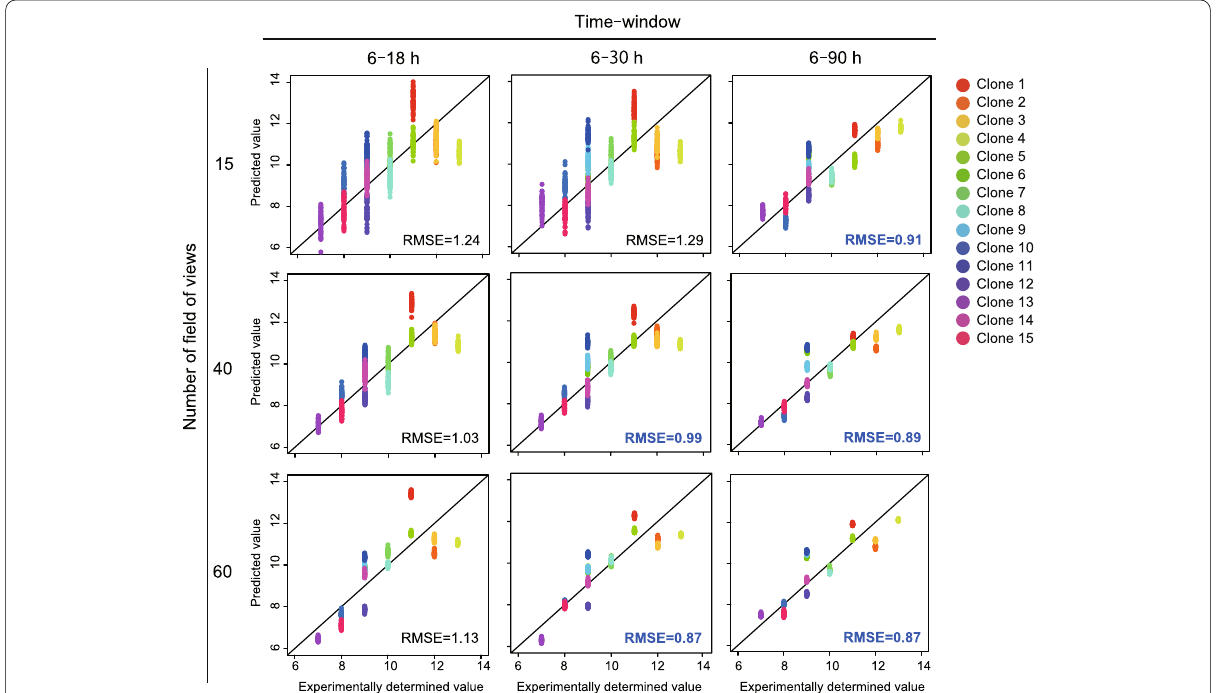
Fig. 5 Evaluation of the robustness of serial-passage prediction models against data variation included by the bootstrap FOV selection (50 repeats) and its data-usage